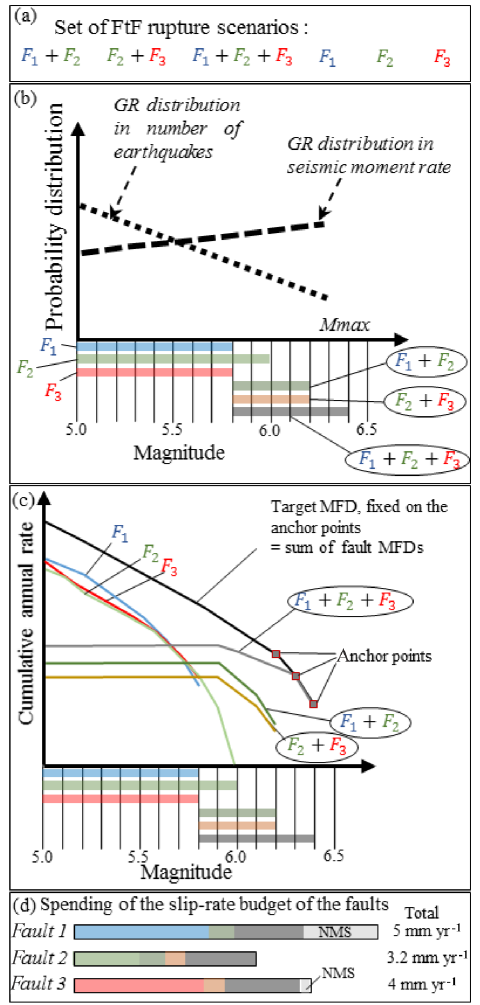
Figure 1. Illustration of the methodology. (a) Set of FtF rupture scenarios. (b) Picking of the magnitude bins and of the sources. (c) Building the target MFD: the black curve is the target MFD an- chored at the mean of the three highest magnitude bins (magnitude bin of 0.1). The sum of the resulting MFDs of the six sources has to be equal to the target MFD. (d) Visualization of the partitioning by the iterative methodology of each fault’s slip-rate budget (col- ors correspond to the individual rupture or the FtF rupture; NMS is non-main-shock